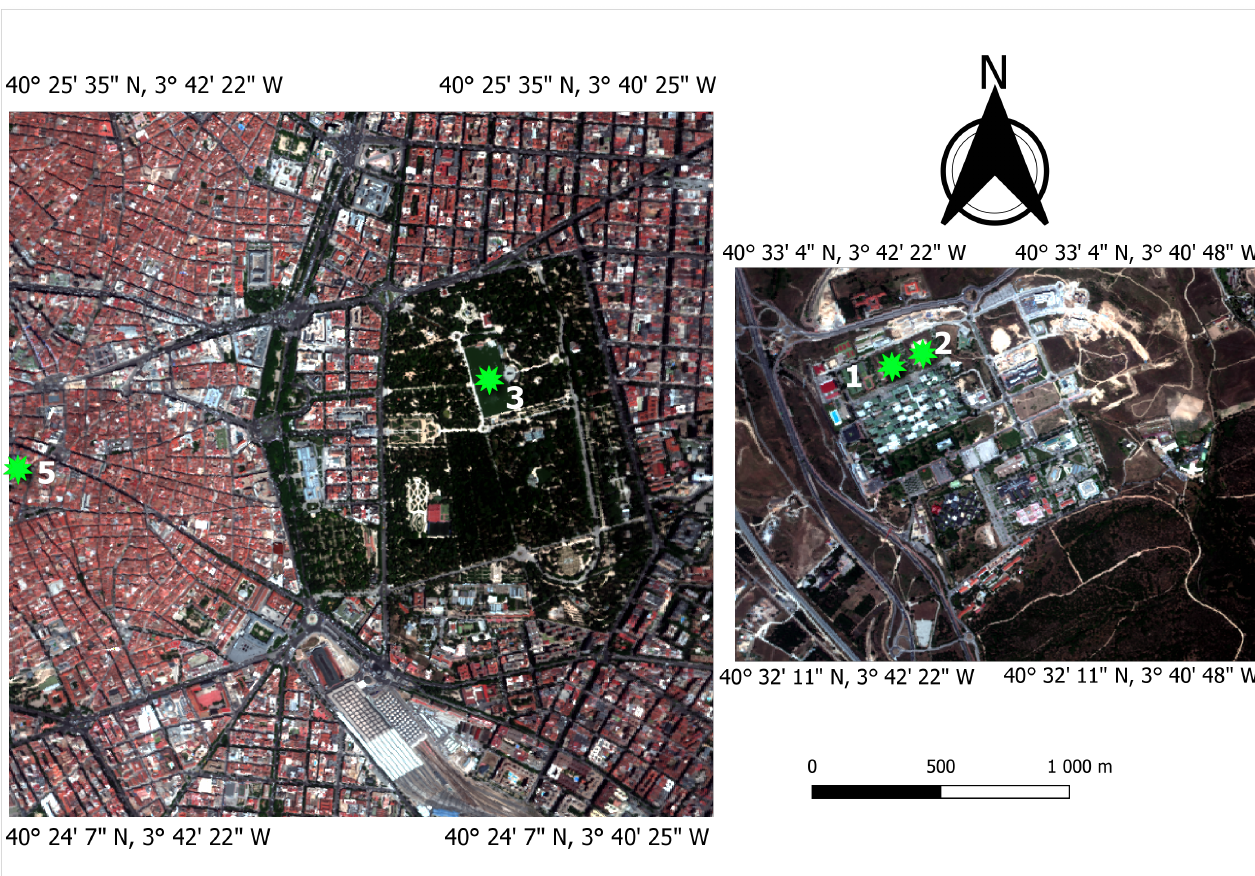
Figure 2. RGB AHS image for the 4 of July 2008 over the two areas shown for visual analysis: the Retiro Park ( left ) and the UAM ( right ). Stars point out the calibration and validation surfaces used during the ESA-DESIREX campaign, with numbers in correspondence with Table 2. The water lake is at the center of the Retiro Park, highlighted by the number three. The big gray roofs under the Retiro Park are part of the Atocha train